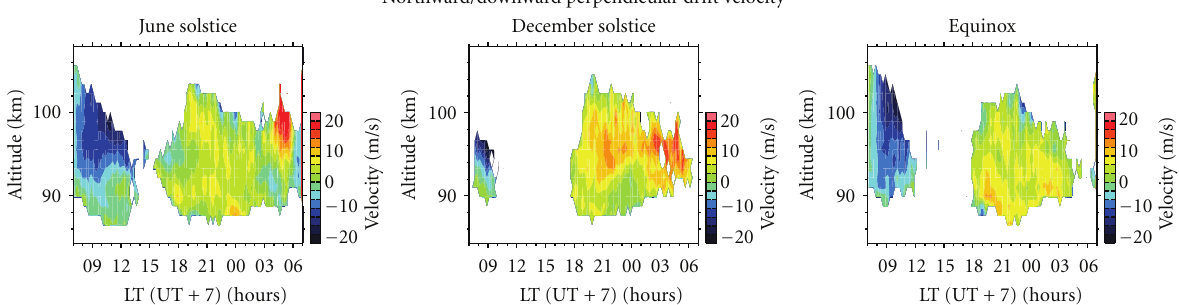
Figure 4: Local time and altitude variations of averaged Doppler velocity of the E -region FAIs in the southward/downward perpendicular direction to the magnetic fields (a) June solstice, (b) December solstice, and (c) equinox seasons in